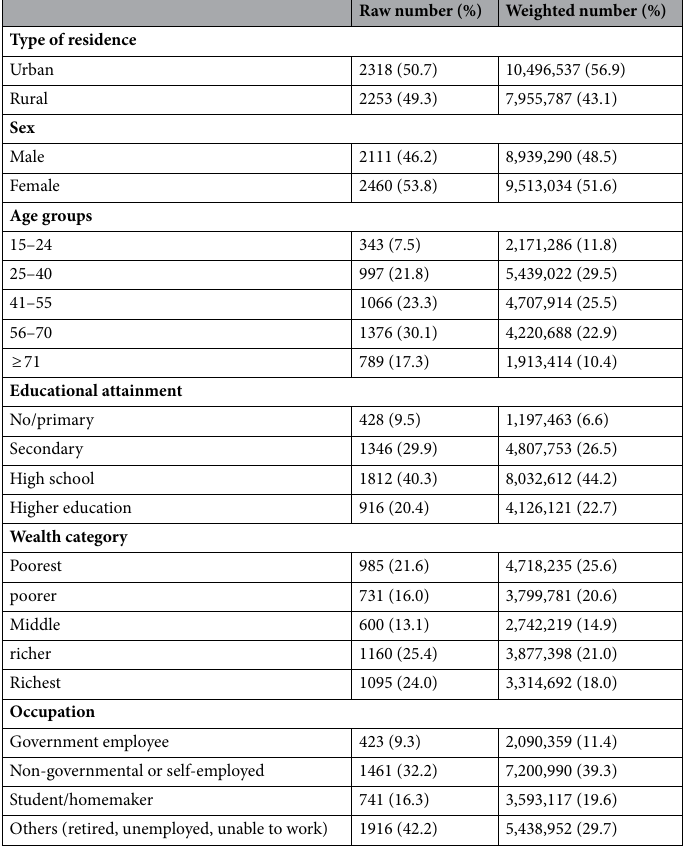
Table 1. Raw numbers, weighted numbers and proportions of socio-demographic characteristics of adults in Romania GATS 2018.